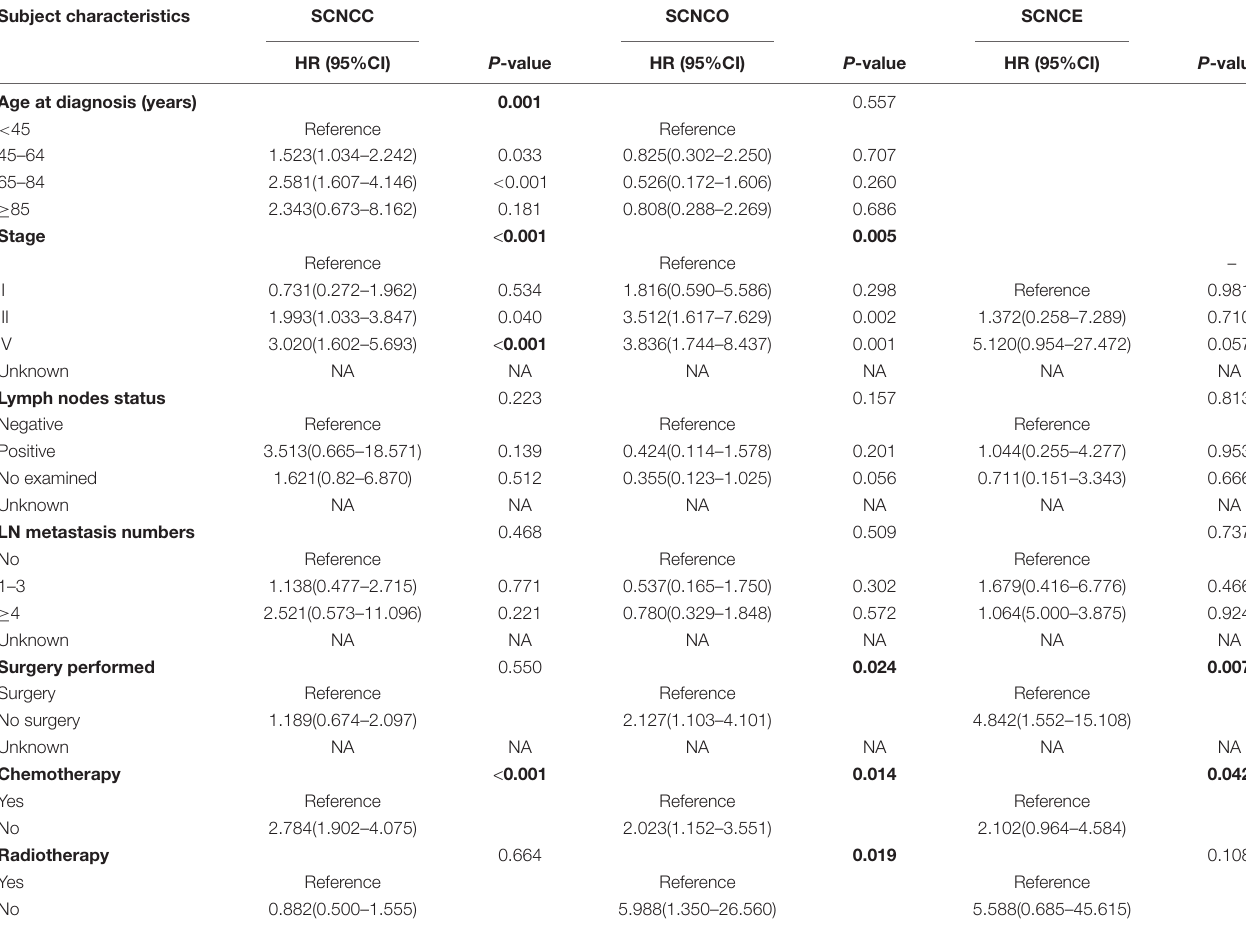
TABLE 3 | Multivariable Cox regression for analyzing the prognosis factors for small-cell neuroendocrine carcinoma of the gynecologic tract